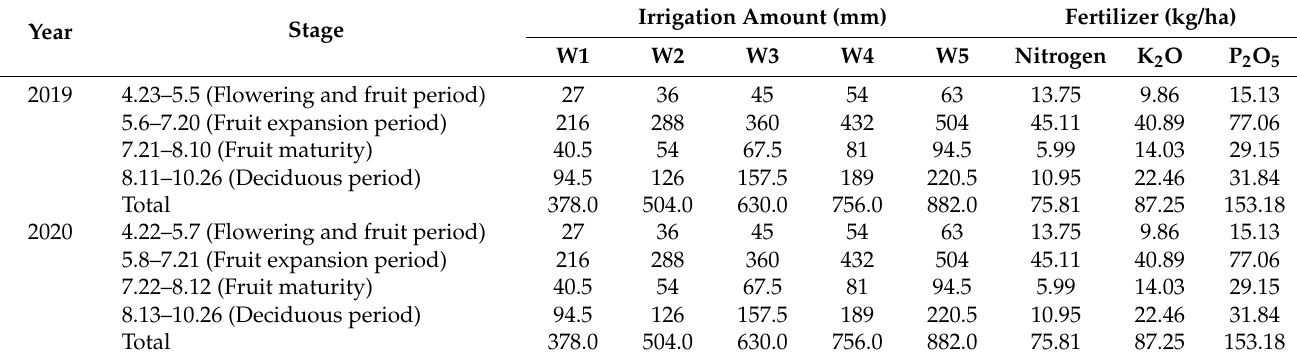
Table 2. Irrigation and fertilizer amount of five irrigation treatments in each month of apple trees in 2019 and 2020. Year